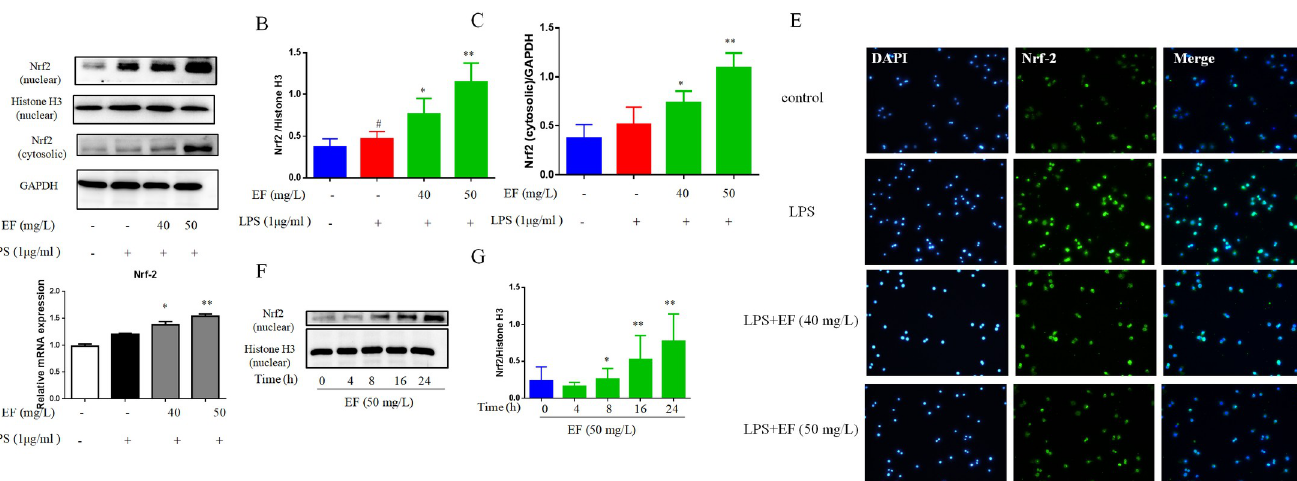
PLOS ONE | https://doi.org/10.1371/journal.pone.0251578 May 26,